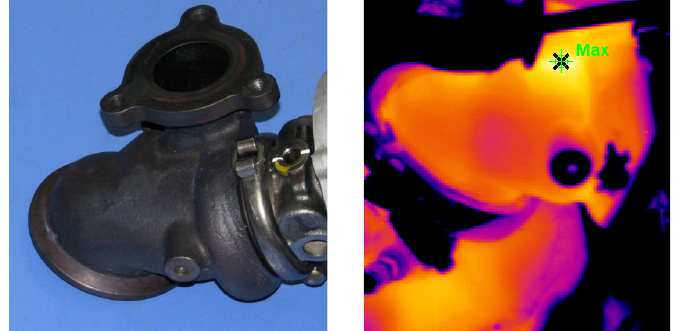
Figure 14. The area on the turbine housing that is machined.